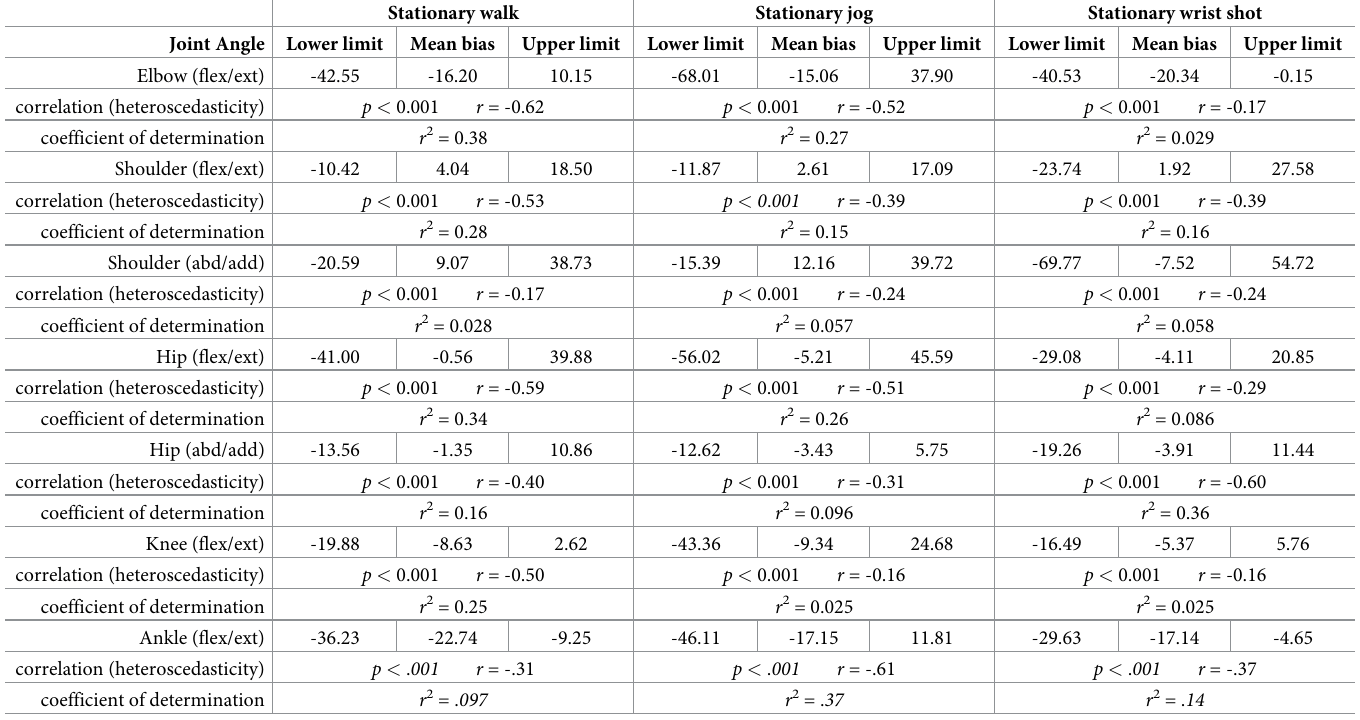
Table 5. Limits of agreement and mean bias for all stationary